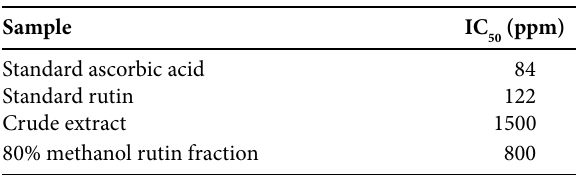
Table 2 . Scavenging activity of standard chemicals and plant sam- ples at 50%